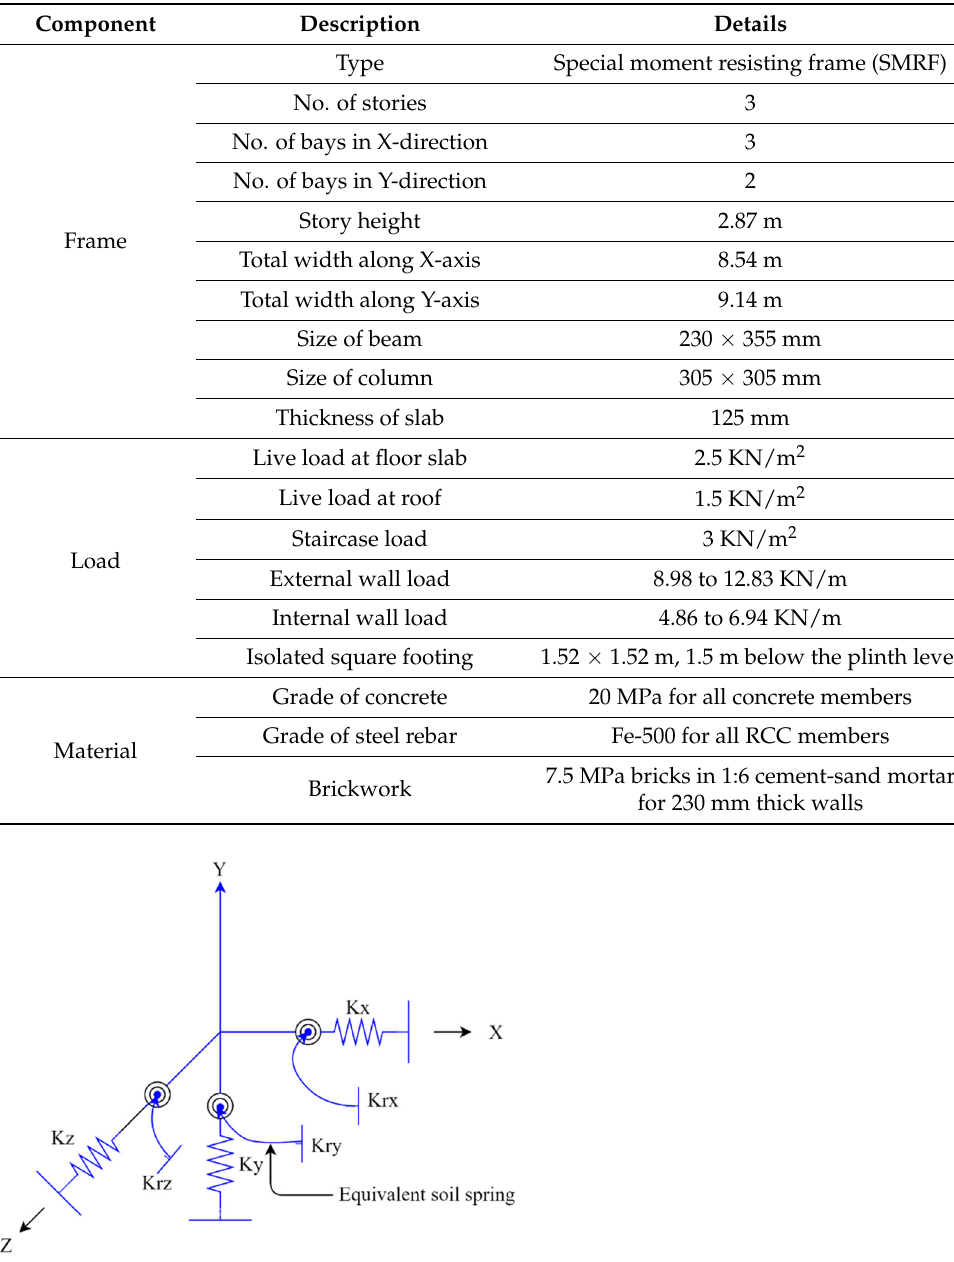
Figure 5. Equivalent soil spring model with six degrees of freedom [37].